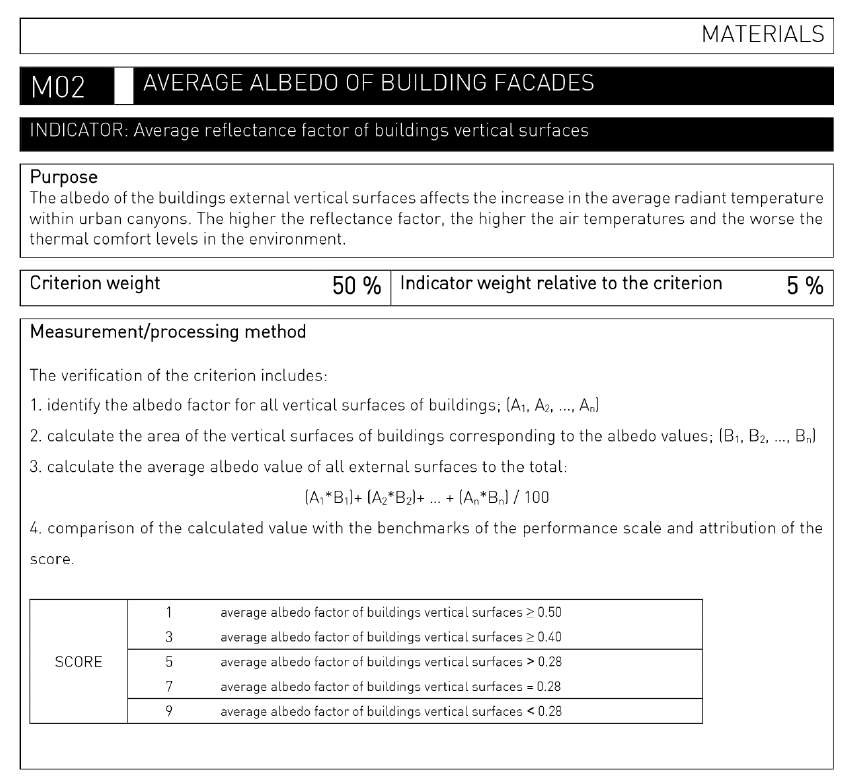
Figure A10. Descriptive sheet of the indicator of “Average albedo of building facades”.